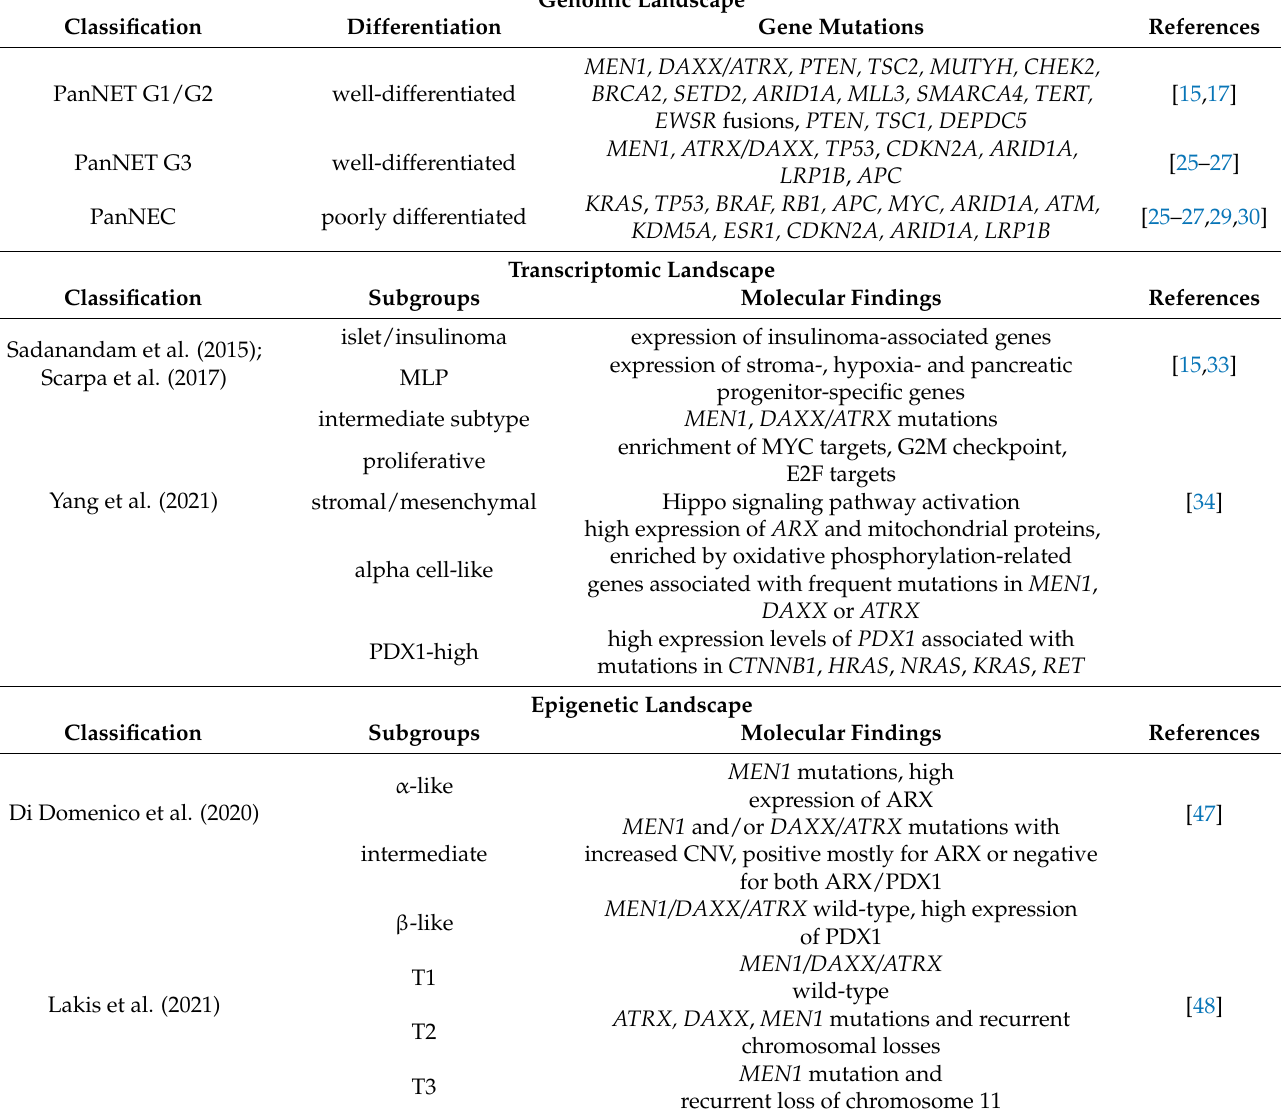
Table 1. The genomic, transcriptomic, and epigenetic landscape in sporadic PanNENs. MLP: metastasis-like primary, CNV: copy-number